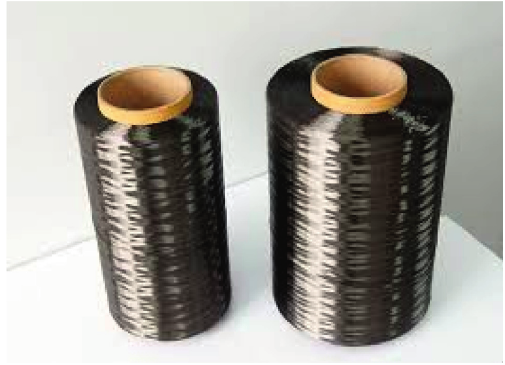
Figure 1: Appearance of the tow carbon